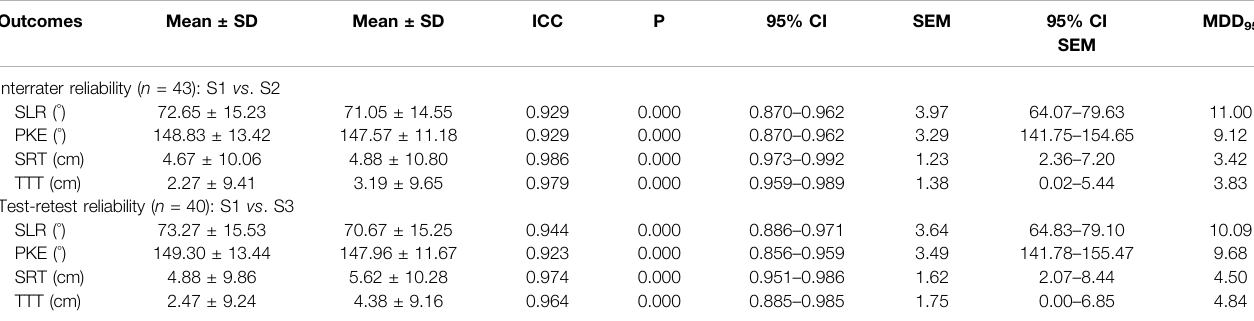
TABLE 2 | Measurement reliability of four common clinical tests for assessing hamstring fl exibility in young adults. Outcomes